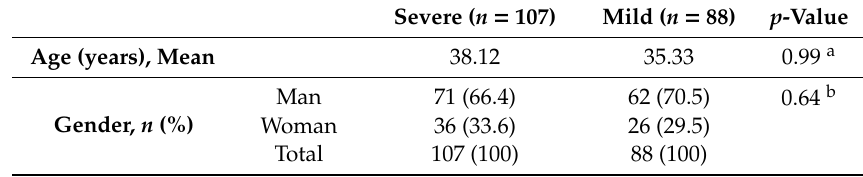
Table 1. Hantavirus cardiopulmonary syndrome (HCPS) patients’ demographic characteristics.